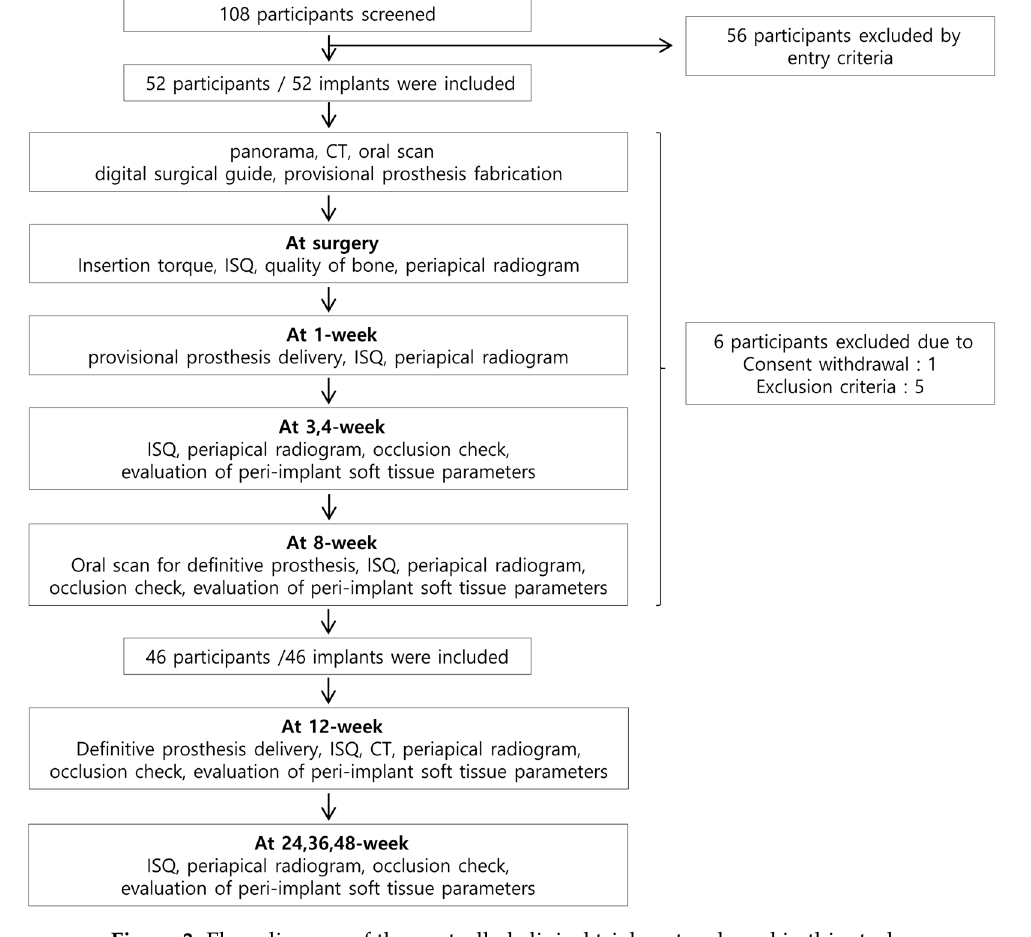
Figure 3. Flow diagram of the controlled clinical trial protocol used in this study.